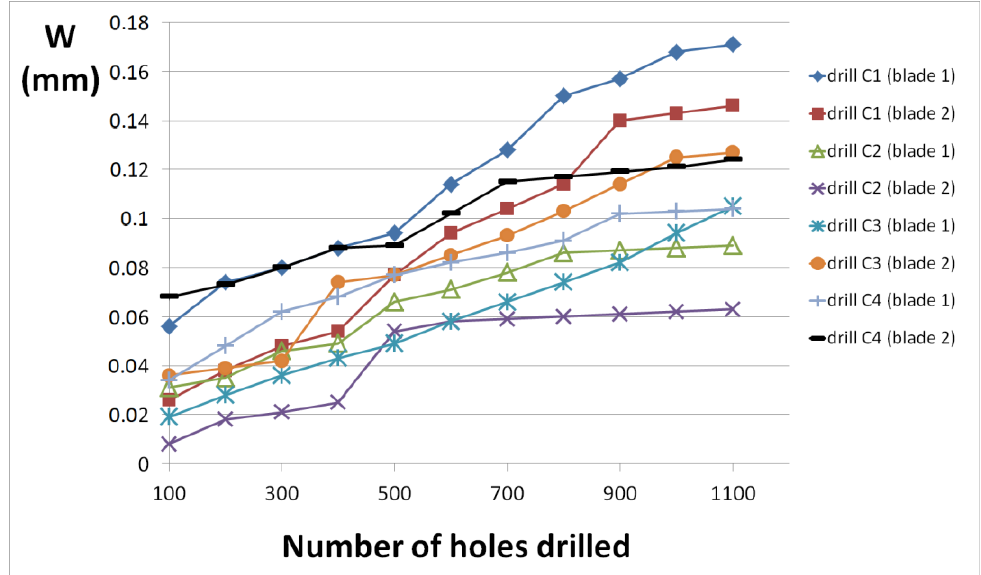
Figure 11. The blade wear curves for drill bits from Group C (experimental group containing four two-blade tools that were coated with “TiAlN/a-C:N”). R 2 stands for the coefficient of determination.